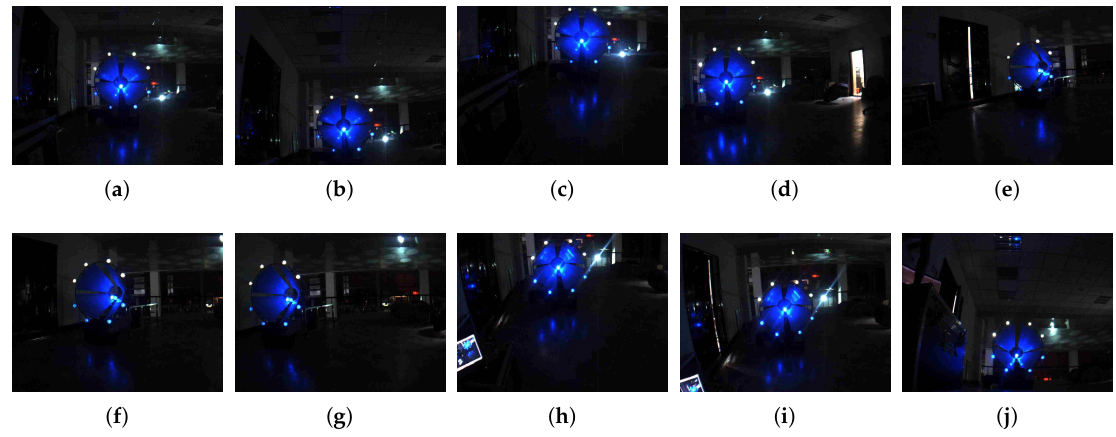
Figure 9. Landmarks for pose estimation in ground experiments.